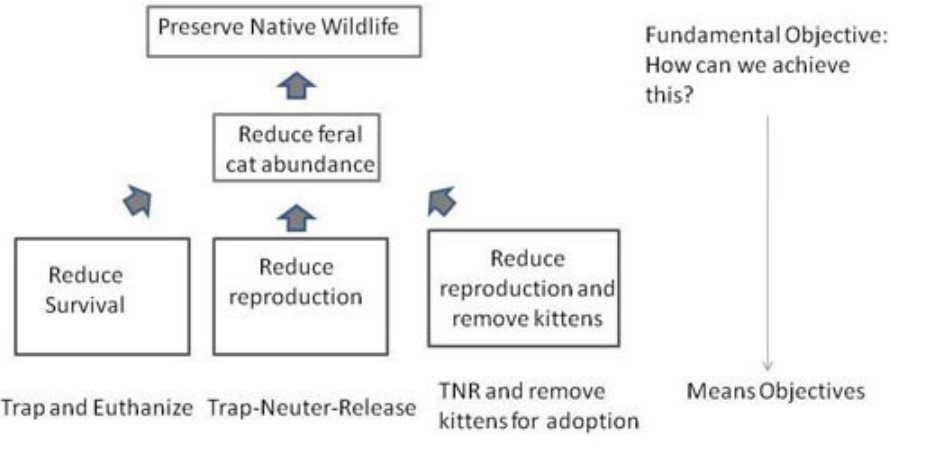
Fig. 2 . Influence diagram guiding development of our feral cat management Bayesian Belief